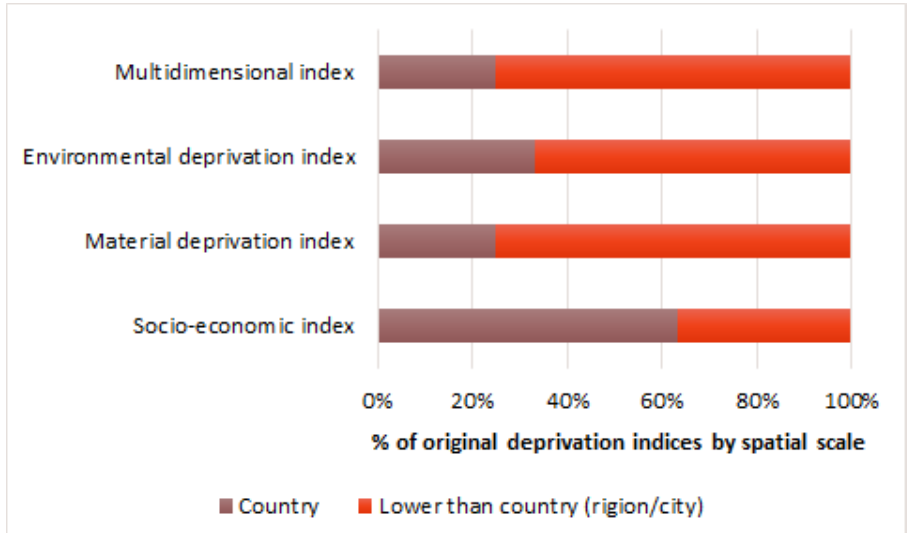
Figure 4. Original deprivation indices grouped by spatial